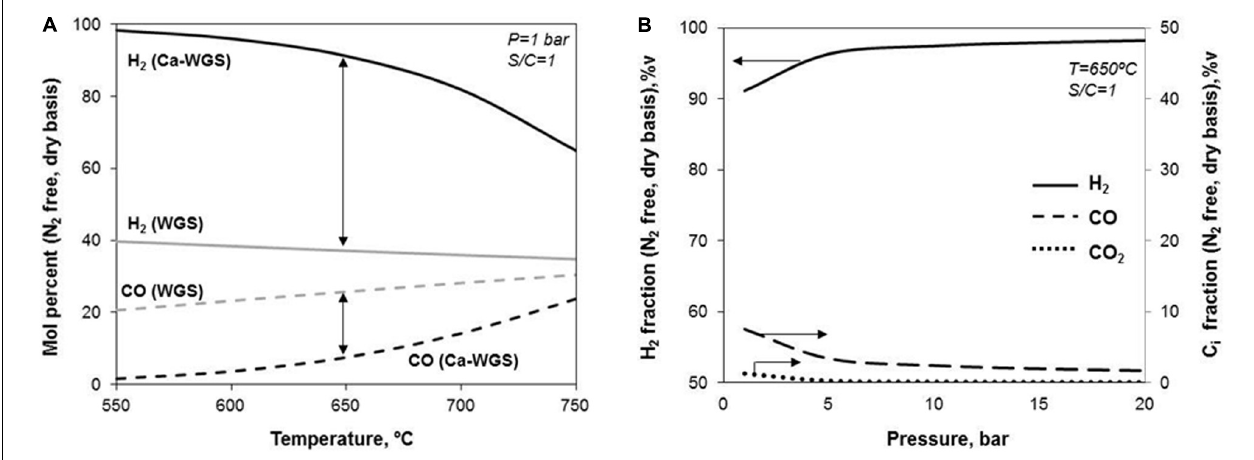
FIGURE 4 | (A) Equilibrium of WGS reaction as a function of the temperature with and without CaO-based sorbent; (B) effect of pressure on Calcium assisted WGS reaction.